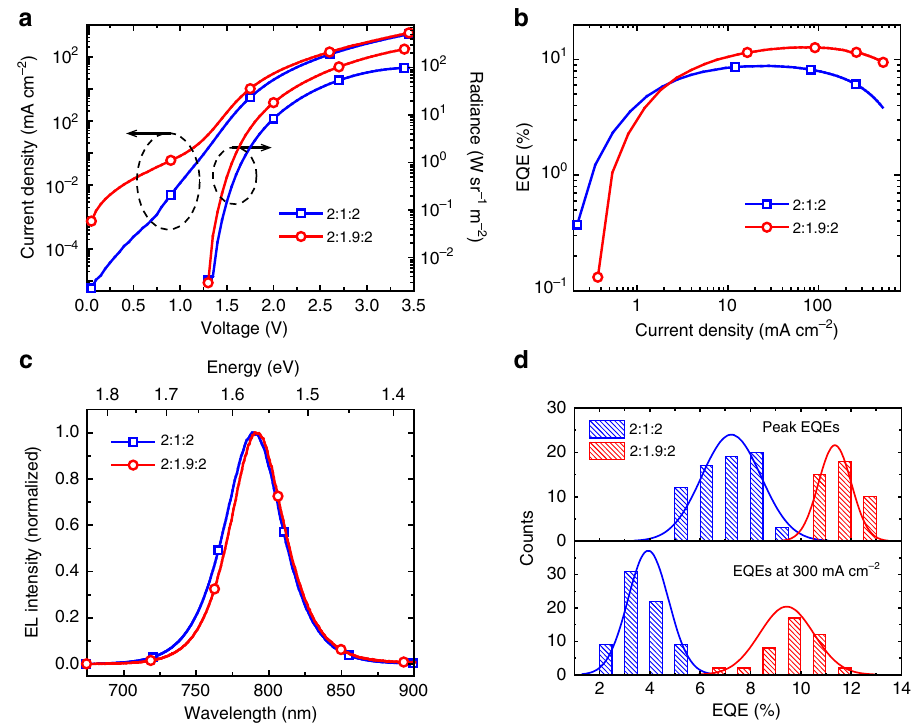
Fig. 4 Optoelectronic characteristics of the perovskite MQW LEDs. a Dependence of current density and radiance on the driving voltage. The peak radiance of 254 W sr − 1 m − 2 is obtained under 3.45 V for the 2:1.9:2 devices. This is a brightness record for solution-processed NIR LEDs. b EQE versus current density. For the 2:1.9:2 MQW LED, a peak EQE of 12.7% is achieved at a current density of 80 mA cm − 2 . The EQE of the 2:1.9:2 device remains to be approximately 10% at 500 mA cm − 2 , due to a signi fi cantly suppressed EQE roll-off. c EL spectra of the 2:1:2 and 2:1.9:2 MQW LED devices. d Histograms of peak EQEs and EQEs at a high current density (300 mA cm − 2 ). Statistics of 71 2:1:2 devices show an average peak EQE of 7.2% (a relative standard deviation of 16.3%) and an average EQE of 4.0% at 300 mA cm − 2 (a relative standard deviation of 20%). Peak EQEs of 43 2:1.9:2 devices were measured under the same condition, which shows an average EQE of 11.3% (a relative standard deviation of 5.7%) and an average EQE of 9.4% at 300 mA cm − 2 (a relative standard deviation of